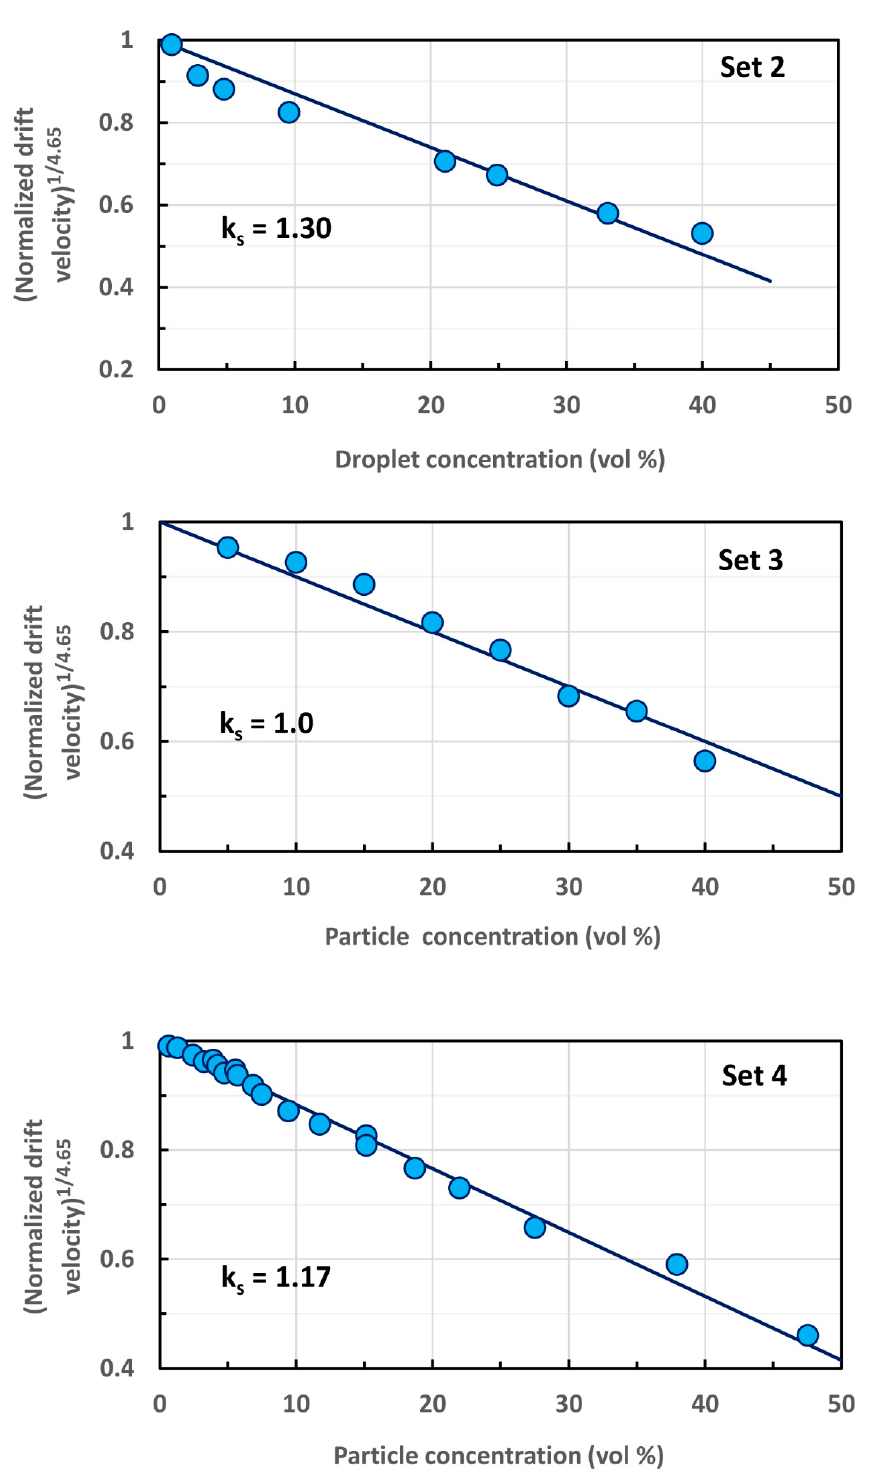
(cid:2869)/(cid:2872).(cid:2874)(cid:2873) (cid:105) 1/4.65 versus 𝜙 experimental data. Figure 6. Typical plots of (cid:104) U versus φ experimental Drift , N